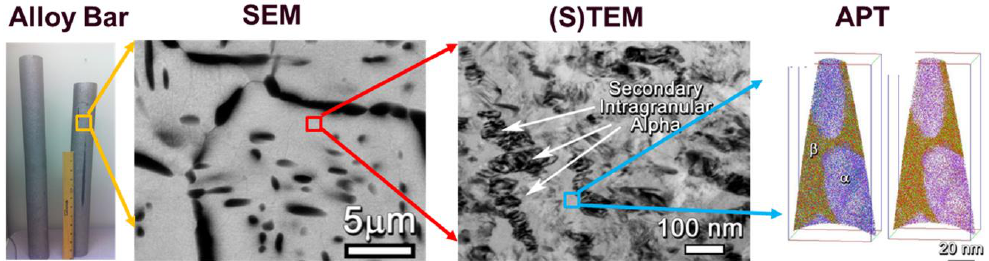
Figure 6. The microstructure and nanostructure of a metastable Ti-1Al-8V-5Fe (wt. %) alloy with a hierarchical nanostructure achieved by sub-transus solution heat treatment and isothermal aging. The alloy powder feedstock was processed by the TiH 2 based powder process.